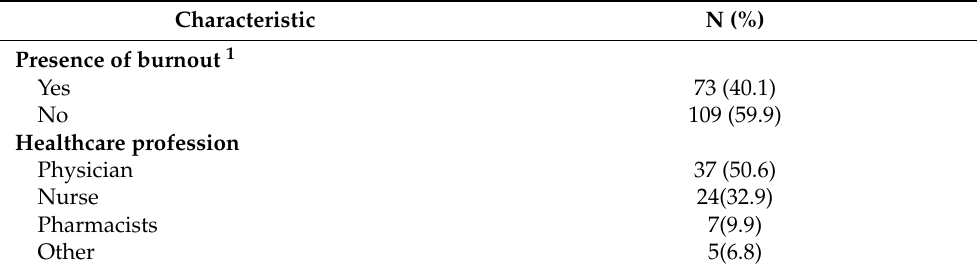
Table 3. Burnout among participants (N = 182)